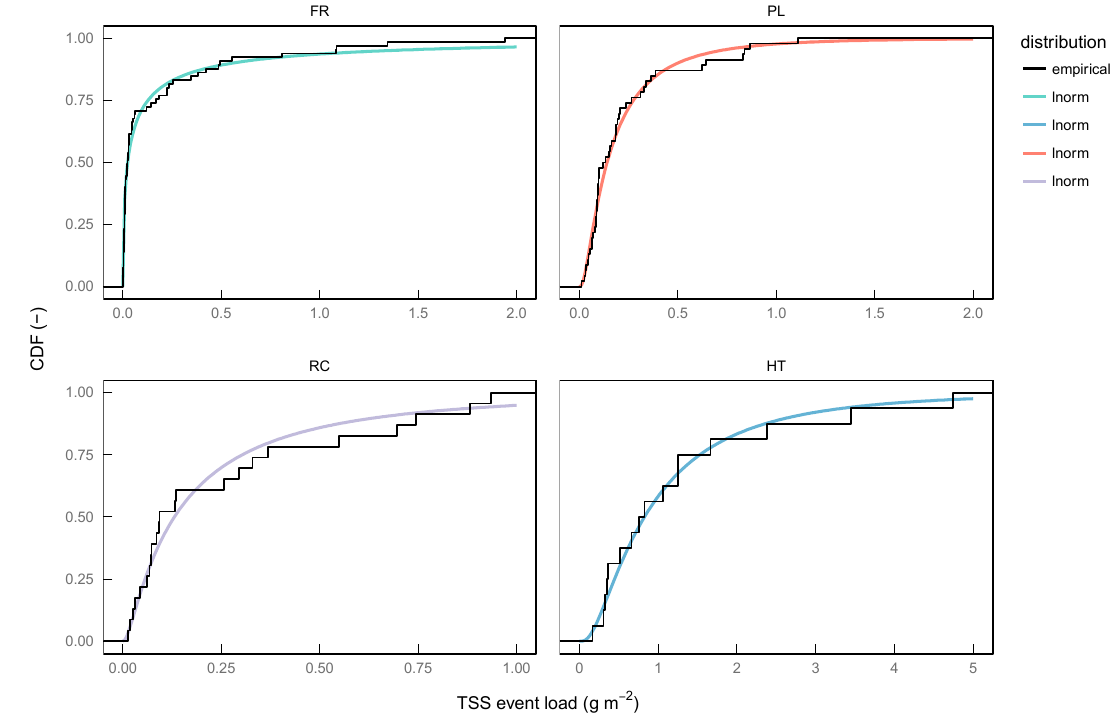
Figure 2. Approximation of empirical TSS event load distribution function with lognormal distribution function at all sites.